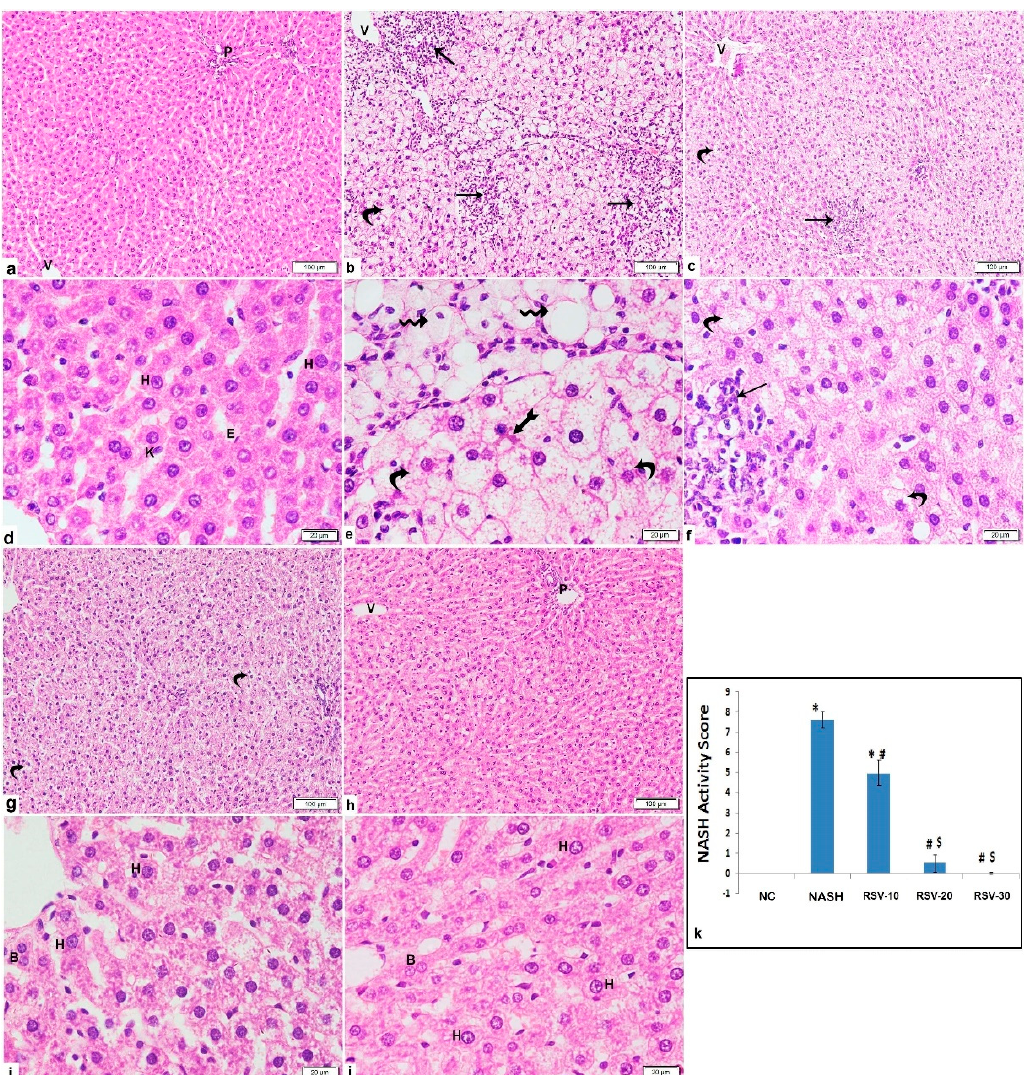
Figure 2. Photomicrographs of H&E ‐ stained liver sections show: Photomicrographs of H&E ‐ stained liver sections show: ( a , d ) NC: normal architecture displays portal tract (P), central vein (V) and radiating cords of hepatocytes separated by blood sinusoids. The hepatocytes illustrate acidophilic cytoplasm and vesicular nuclei with prominent nucleoli (H). The blood sinusoids are lined with endothelium (E) and Kupffer cells (K). ( b , e ) NASH: obvious damage of liver tissue with large areas of inflammatory cells infiltration (arrow), involving all zones; peri ‐ central (zone3), mid ‐ lobular (zone2) and peri ‐ portal (zone1), widespread ballooning of hepatocytes illustrating micro ‐ vesicular vacuolations (curved arrow) and dilated central veins (V). Some cells show one large ‐ sized cytoplasmic vacuole (wavy arrow) with eccentric or peripheral flattened nuclei others display acidophilic cytoplasmic Mallory ‐ Denk body (bifid arrow). ( c , f ) RSV ‐ 10: focal area of inflammatory cells infiltration (arrow) among the hepatocytes in zone2, micro ‐ vesicular cytoplasmic vacuolation of hepatocytes (curved arrow) and dilated central vein (V). ( g , i ) RSV ‐ 20: preserved architecture with some hepatocytes displaying variable cytoplasmic vacuolation. The hepatocytes display acidophilic cytoplasm and either vesicular nuclei and prominent nucleoli (H), dark nucleus (arrowhead) or binucleation (B). ( h , j ) RSV ‐ 30: preserved architecture with central vein (V), portal tract (P) and most of hepatocytes illustrate acidophilic cytoplasm. (Inset): hepatocytes with vesicular nuclei and prominent nuclei (H) and binucleation (B). (K) The mean of NASH liver scoring (±SD) in the control and the experimental groups: * p < 0.05 compared to the NC; # p < 0.05 compared to NASH; $ p < 0.05 compared to RSV ‐ 10. [Magnification: 100×; 400×].